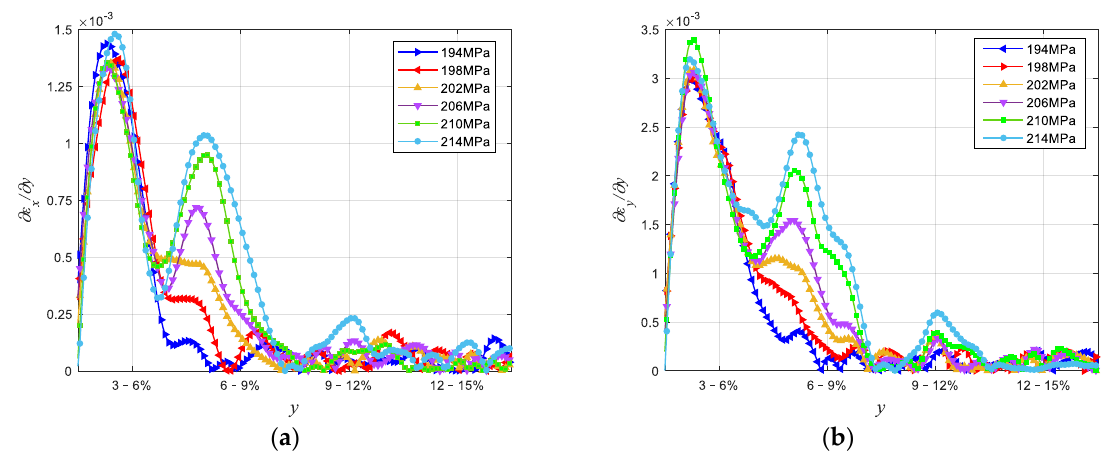
Figure 7. The strain curve for the y-coordinate between A and B on the axis of the specimen: ( a ) the transverse strain curves; ( b ) the longitudinal strain curves.